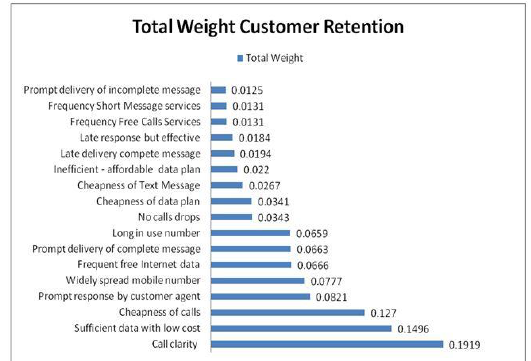
Figure 4.2. Horizontal bar chart for total weight of customers` retention